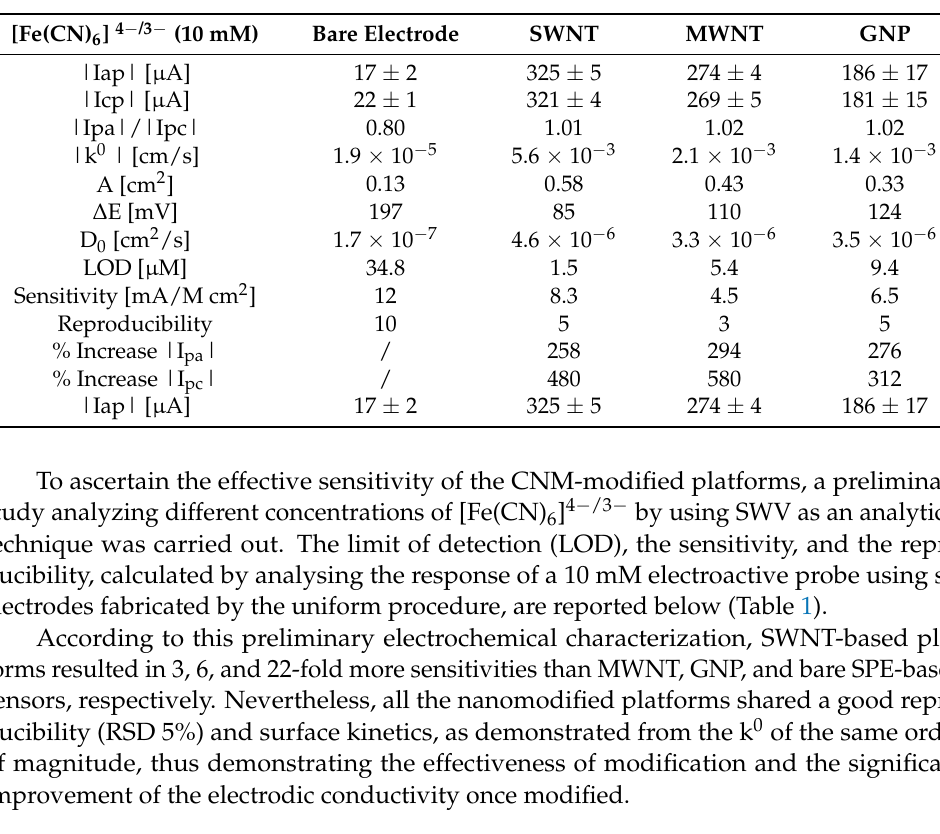
Figure 4. Electrochemical characterization of electrode interface after CNM modification. ( a ) Comparison of the cyclic voltammograms, ( b ) scan rate study (for MWNT-based SPEs), and ( c ) linear regression of SWNTs, MWNTs, GNPs, and bare SPEs obtained using 10 mM [Fe(CN) 6 ] 4 − /3 − in 0.05 M PBS. Curves of one representative CNM-modified SPE sensor of at least 6 analyzed platforms are presented. Table 1. Cathodic and anodic peak current intensity and their ratio, electron transfer rate constant (k 0 ), peak-to-peak separation ( ∆ V), LOD, sensitivity, reproducibility (RSD%), active surface area (A), diffusion coefficient (D 0 ), and percentage increase estimated for bare and CNM-modified SPEs have been reported. All analytical parameters are obtained from cyclic voltammogram traces.